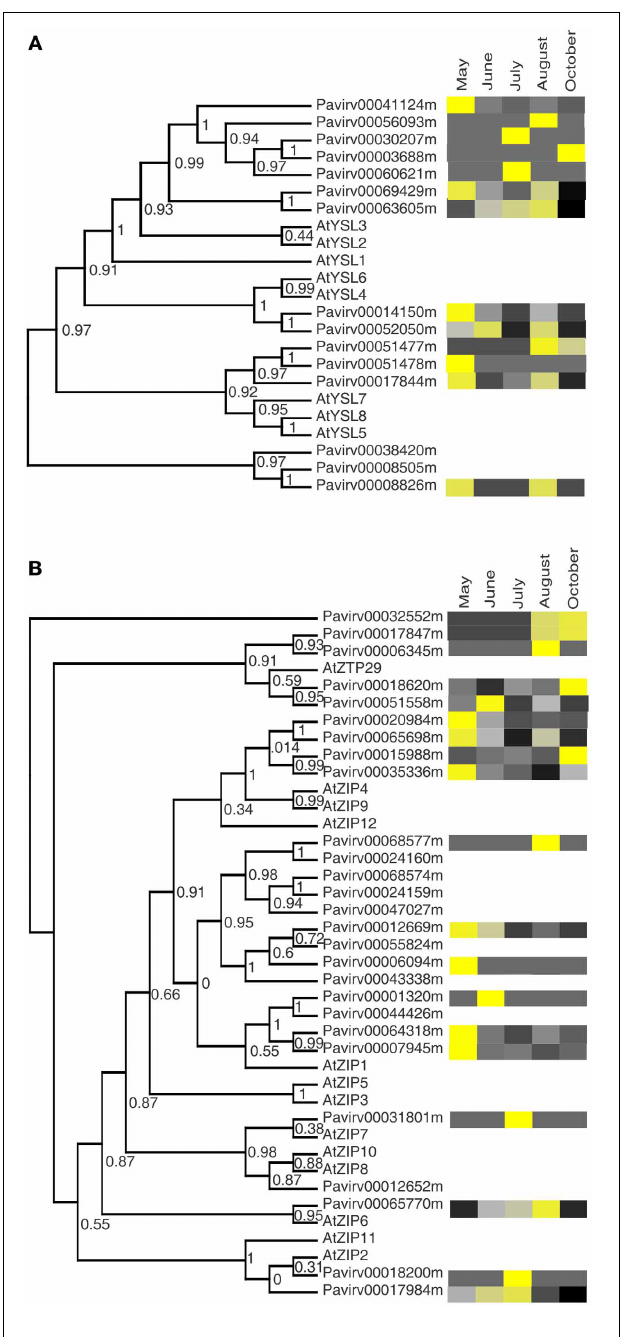
FIGURE 6 | Cladogram of the phylogentic relationships between switchgrass transporter genes to Arabidopsis thaliana orthologs and their expression profiles in crowns and rhizomes of field grown cv Summer plants. (A) Yellow stripe-like transporters (YSL) (B) Zinc transporters (ZIP). Other details are as described for Figure 2 .